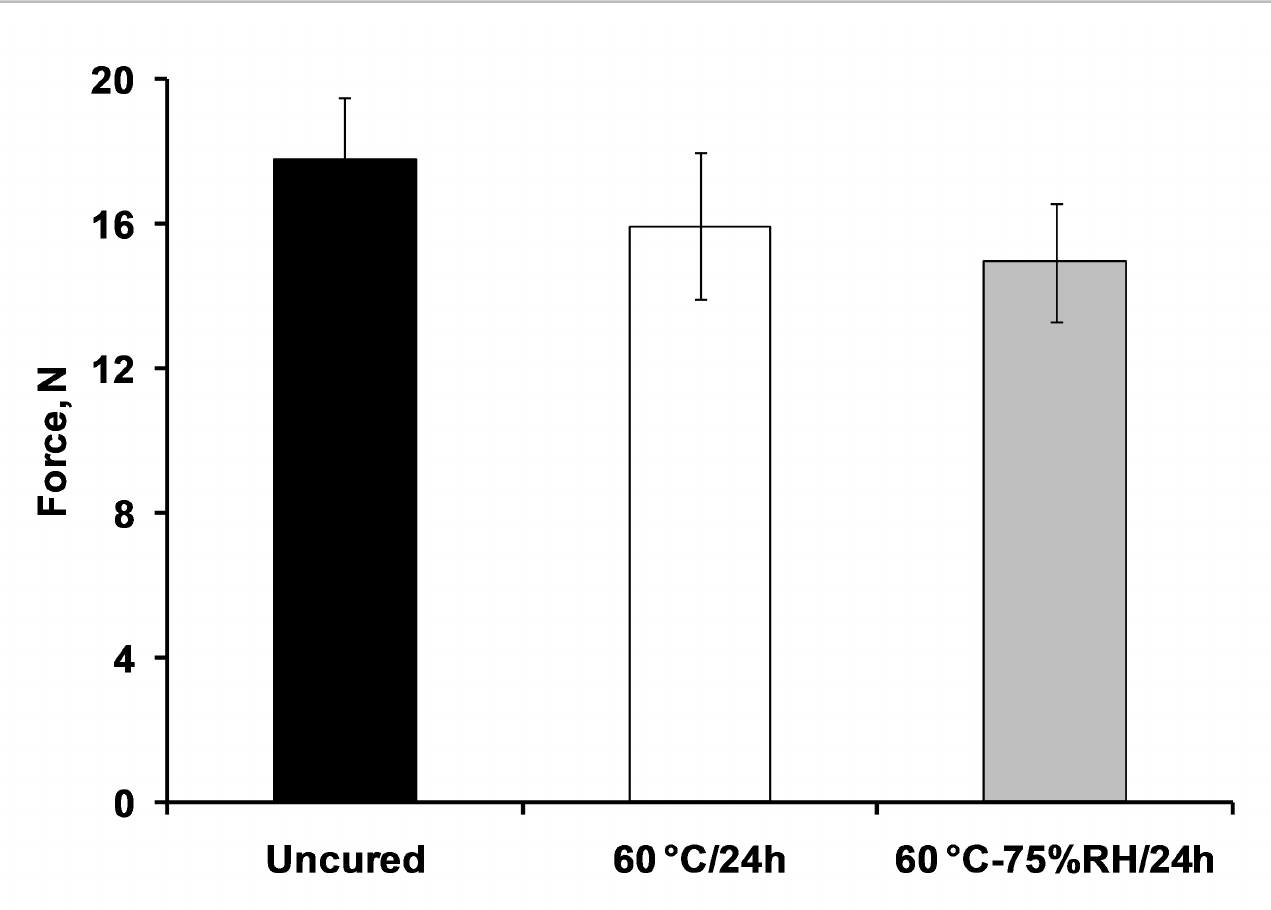
FIGURE 12 - Effect of curing on adhesive force of Eudragit ® NE 30D: Aquacoat ® ECD (25:75) polymeric coatings to the drug- layered-cores using model tablets (drug layered and polymer coated like pellets), coating level